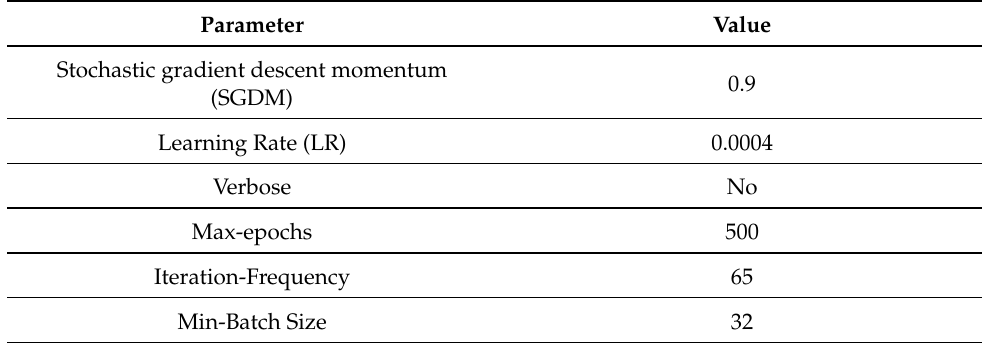
Table 4. The fine-tuned parameters of the proposed